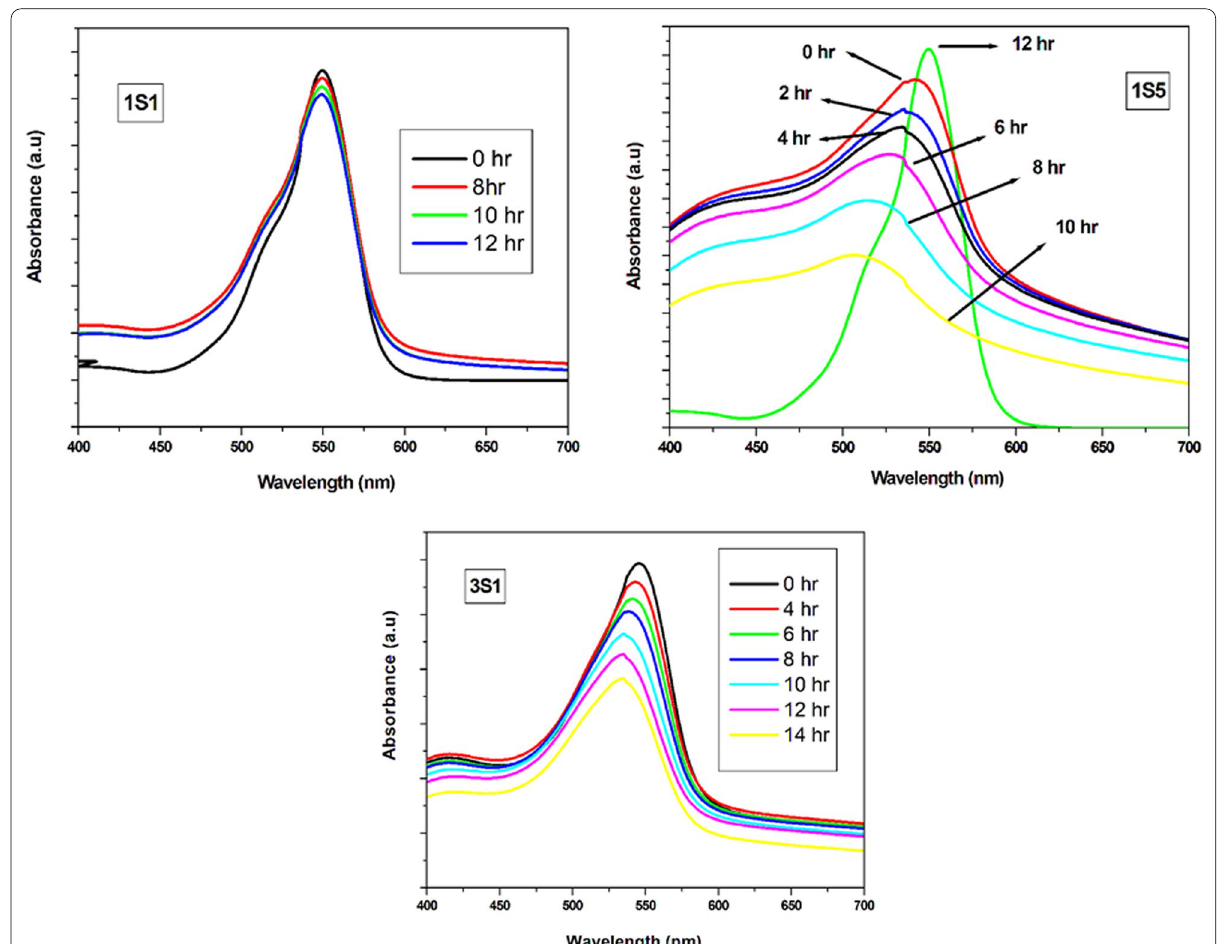
Fig. 5 Time dependence of the optical absorption of 20 µM/L Rhodamine B aqueous solution after direct solar light irradiation for 12 h in the presence of a 1S1, b 1S5, c 3S1